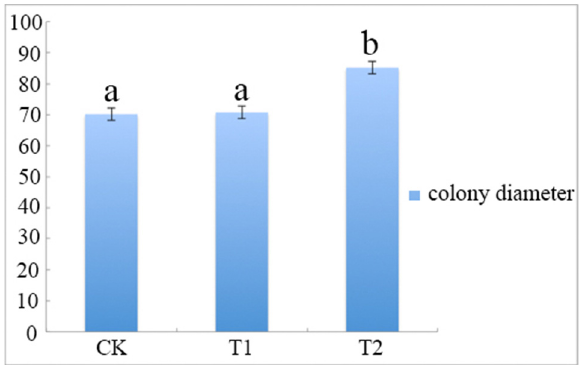
Figure 1. The colony diameter of A. phaeospermum after 7 days of culture under CK, T1 and T2. Note: All assays were repeated three times; the data were analyzed using one-way ANOVA and Duncan’s range test in SPSS 16.0. Different lowercase letters showed that there were significant differences in colony diameter under different treatment conditions ( p ≤ 0.01).